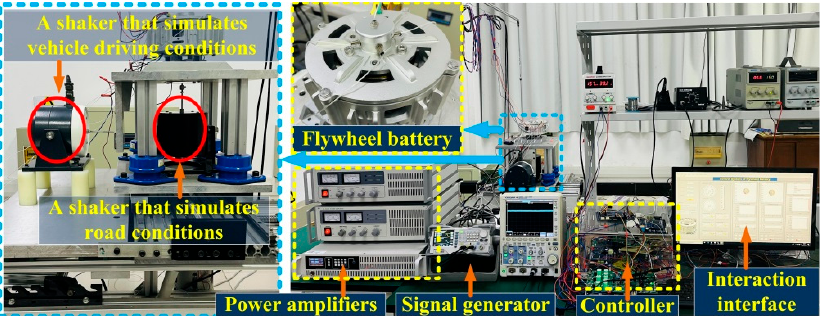
Figure 12. Experimental setup of the prototype considering road surface roughness (simulate with vibrator).